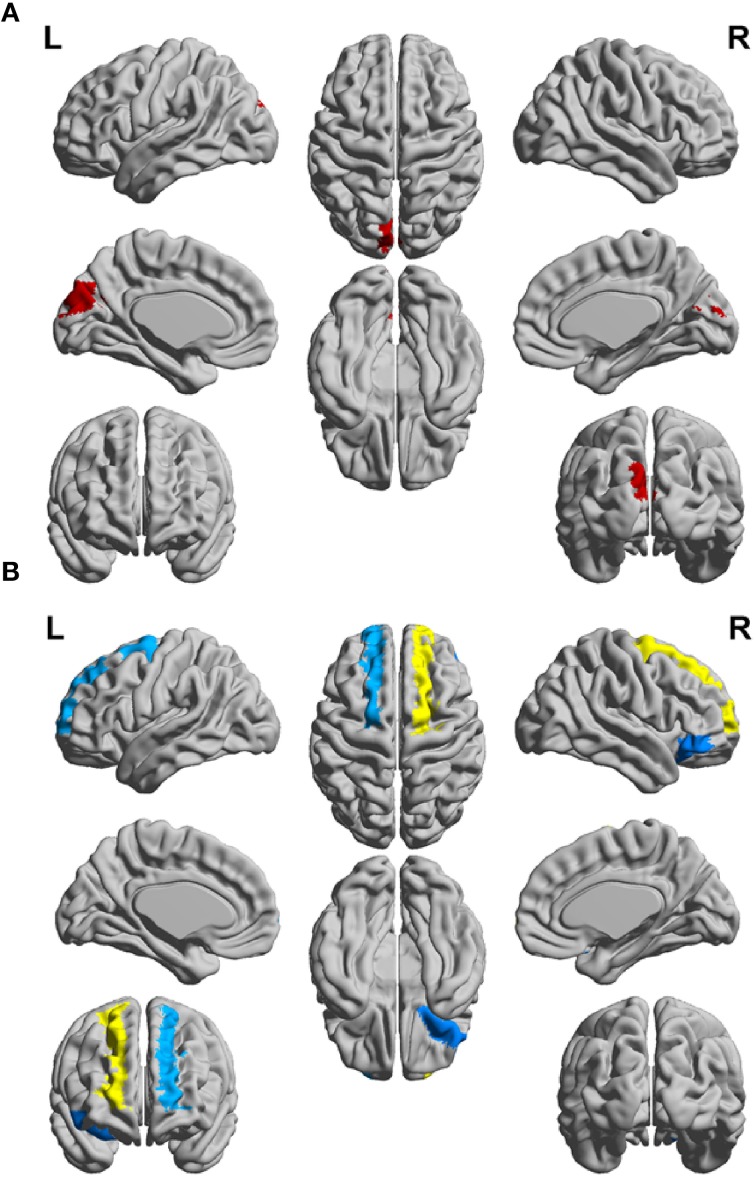
Schematic representation of differences between the CIS and RRMS patient groups for clustering coefficient (CC) of (A) the white matter networks and (B) gray matter networks of the left (L) and right (R) hemispheres.